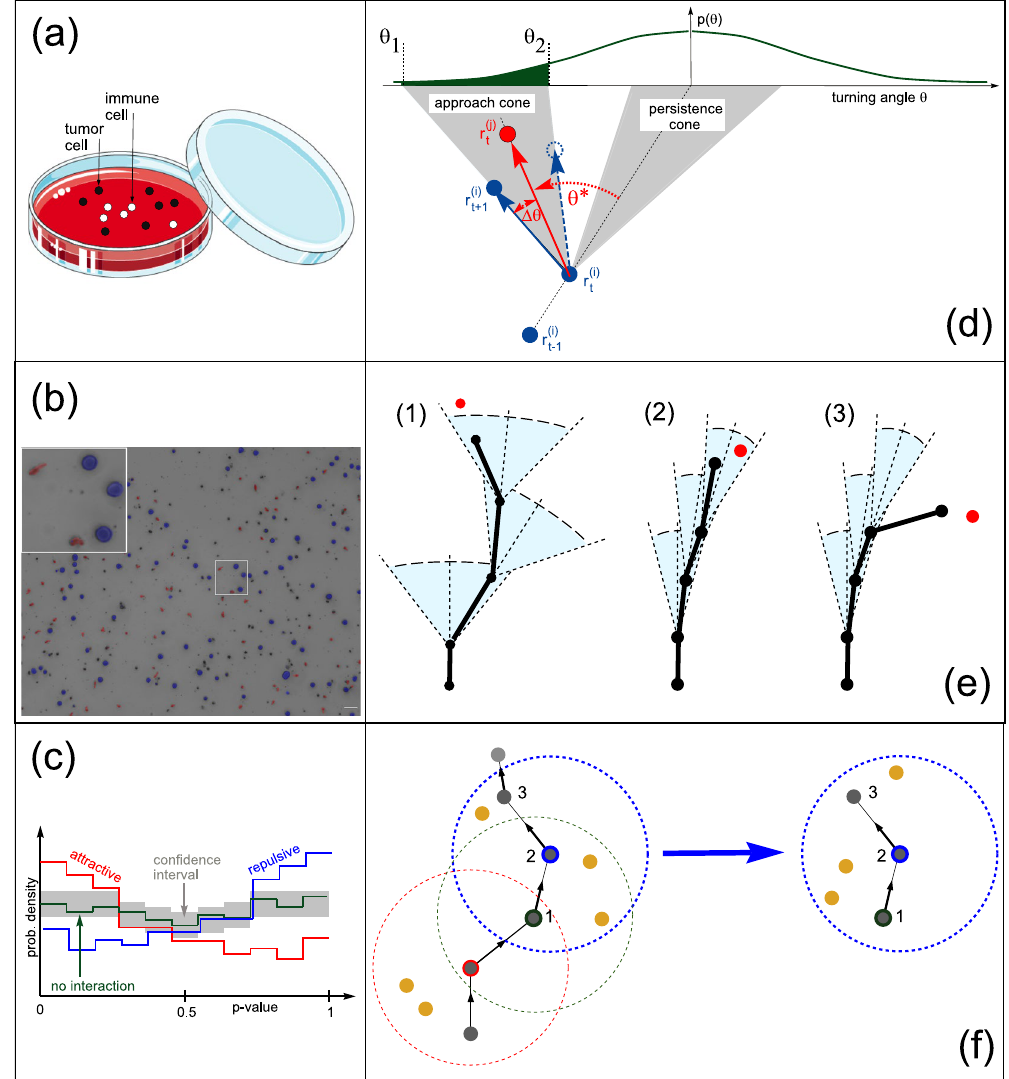
Figure 1. ( a ) Tumor cells and immune cells are randomly dispersed within a suitable 3D matrix. ( b ) Cells are automatically detected, classified and tracked over time. In the example frame, K562 tumor cells are labeled in blue, NK cells in red, non-cell objects in black. The white scale bar in the lower right corner corresponds to 50 µ m. The inset shows the different cell morphologies. ( c ) A p value distribution is computed from the data and compared with a confidence interval corresponding to randomized data. The sketch shows the characteristic signatures of attractive (red) ane repulsive (blue) interactions. ( d ) Computation of the p value (green shaded ( i ) r ( i ) r ( i ) area under the curve p (θ) ). We consider a ‘triplet’, consisting of three consecutive positions ( r t , t − 1 , t + 1 ) of ( i ) the focal immune cell (blue solid circles) and the position r t of a target cell (red circle) in the vicinity. The ‘persistence cone’ (right shaded area) is the interval of the most probable migration directions of a target-blind immune cell, which is determined by the previous migration direction (between time step t − 1 and t ), and by the known turning angle distribution p (θ) (olive curve on the top). The quantity θ ⋆ (red) is the optimal turning angle that would align the immune cell precisely towards the target cell. The approach cone (left shaded area) is the interval of migration directions which are at least as target-oriented as the actual move of the immune cell. By integrating p (θ) over the approach cone (that is, from turning angle θ 1 = θ ⋆ − �θ to θ 2 = θ ⋆ + �θ ), we compute a p value, the probability that a move at least as target-directed as observed could occur in a target-blind random walk . ( e ) Three examples of immune cell trajectories (black) in relation to a target cell (red). Cases (1) and (2) are not indicative of goal-directed migration, but case (3) is ‘suspicious’, because the cell steps out of its persistence cone and is at the same time very target-directed. ( f ) A reference system without interactions between immune and target cells is generated by re-positioning the target cells randomly, while leaving the immune cell trajectory